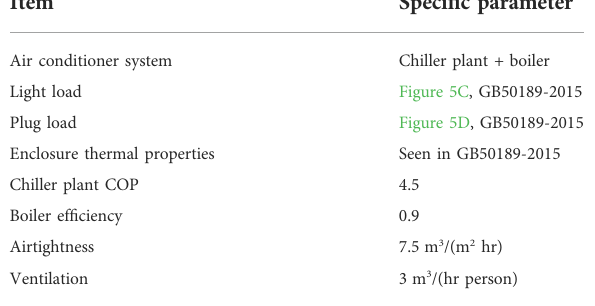
TABLE 1 Building thermal characteristics for